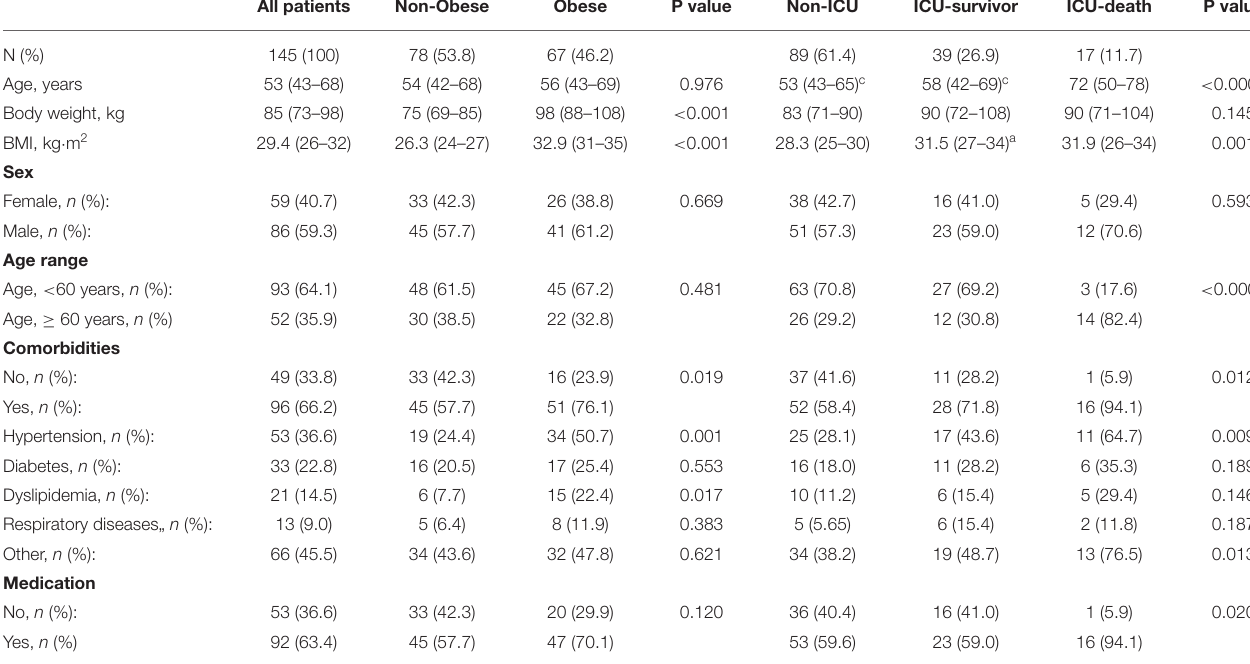
TABLE 1 | Characteristics of patients with Covid-19. All patients Non-Obese Obese P value Non-ICU ICU-survivor